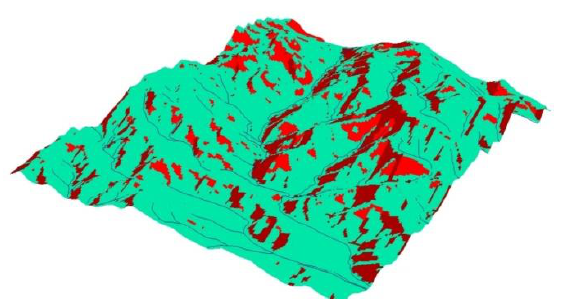
Figure 7. Avalanche zones in the mountainous resort area Shimbulak Trans-Ili